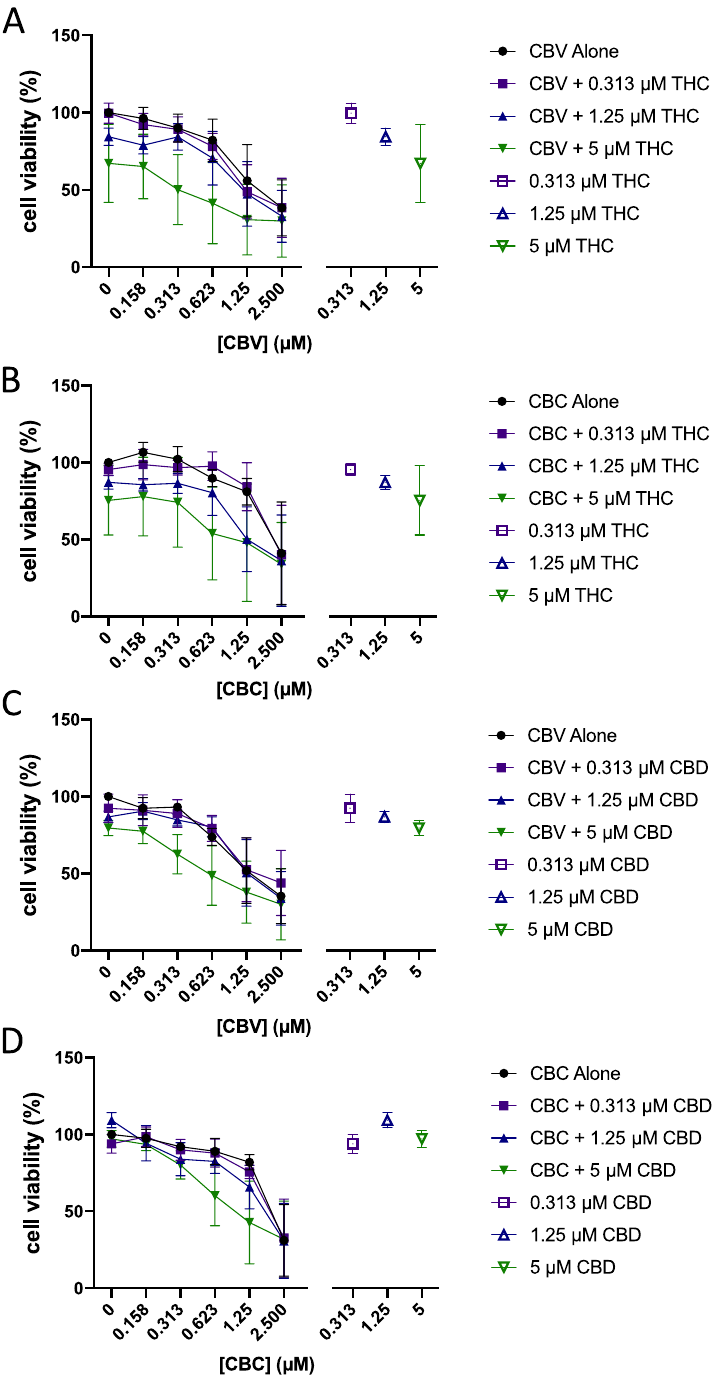
Fig. 7 Assessment of synergy between Δ 9 -tetrahydrocannabinol or cannabidiol and other cannabinoids. Concentration-response curves of CBC or CBV combined with different concentrations of Δ 9 -THC or CBD from the matrix cell viability assay are presented in T24 cells. A Curve of CBV with selected concentrations of Δ 9 -THC. B Curve of CBC with selected concentrations of Δ 9 -THC. C Curve of CBV with selected concentrations of CBD. D Curve of CBC with selected concentrations of CBD. X -axis intervals increase by a value of 2. Hollow points represent cannabinoid effects